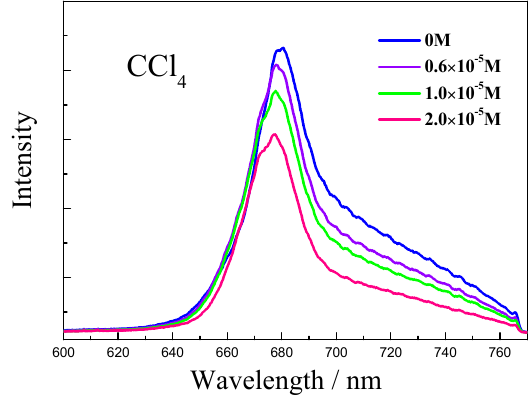
Figure 6. Fluorescence blue-shift with increasing concentration of β -Car.